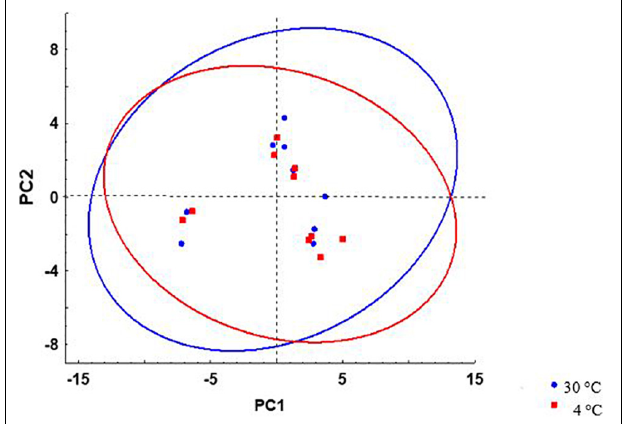
FIGURE 6 | Scatterplots of principal component scores based on lipid composition of L. lota spermatozoa after incubation at 4 and 30 ◦ C. 95% prediction interval ellipses for different temperatures are shown by different colors. Data of samples incubated in AM or SF were included in